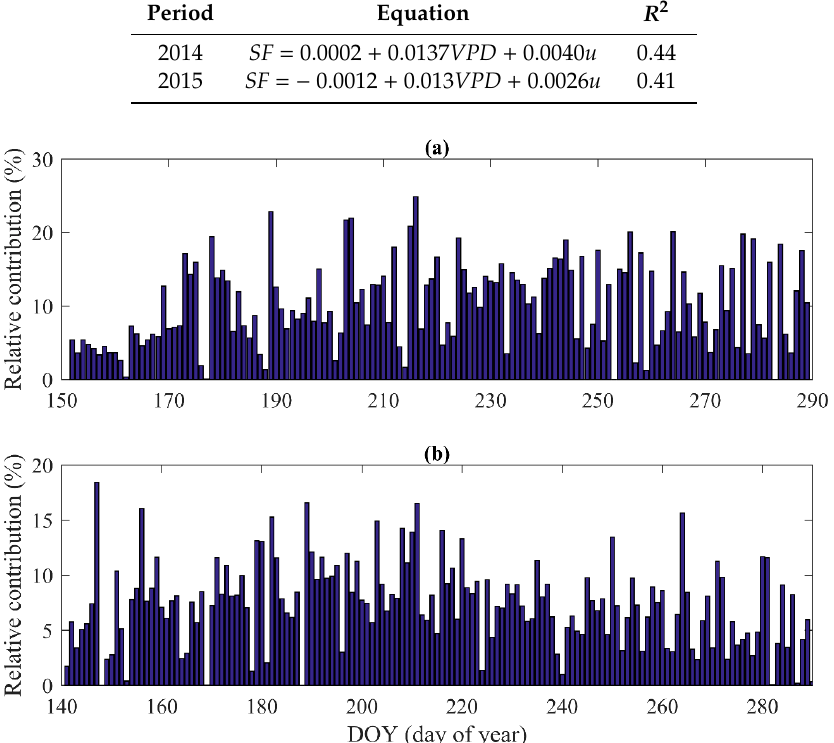
Figure 6. Relative contribution of nocturnal sap flow to daily total water use during the growing season in ( a ) 2014 and ( b ) 2015. Table 5. Multivariate linear equation between nocturnal sap flow and solar radiation, air temperature and vapor pressure deficit.